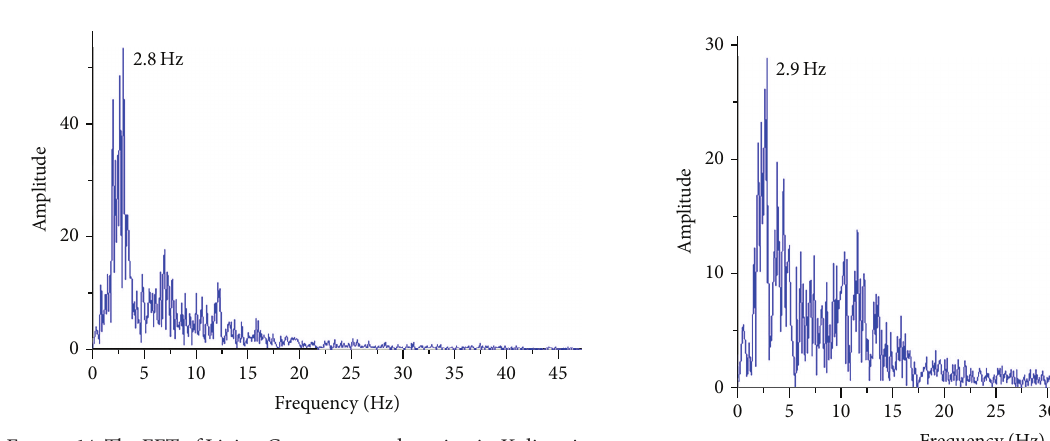
Figure 14: The FFT of Lixian County ground motion in 𝑋 direction.